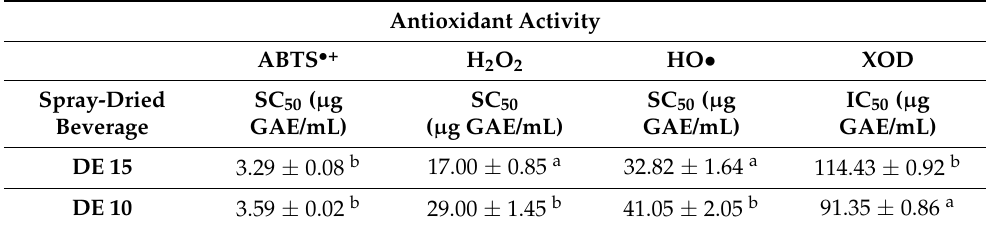
Table 3. Antioxidant capacity of beverage containing chilto juice and Zp